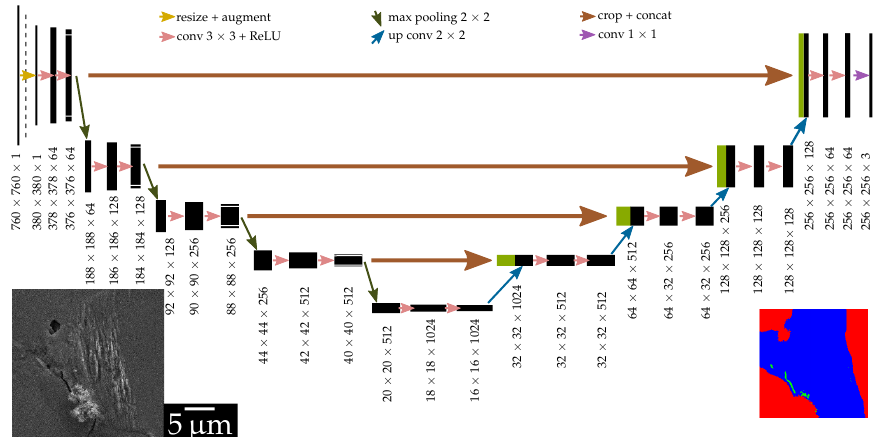
Figure 3. U-Net architecture implemented consisting of four levels with 3 × 3 convolutions and max pooling layers on the encoder section, and up-convolution and 3 × 3 padded convolutions on the decoder section (after